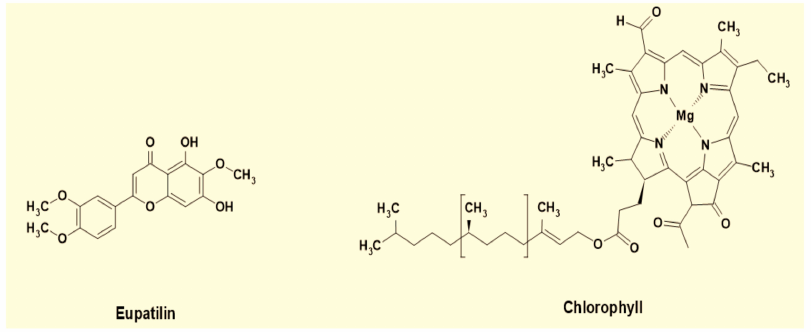
Figure 7. Molecular structure of major components in the extracts.